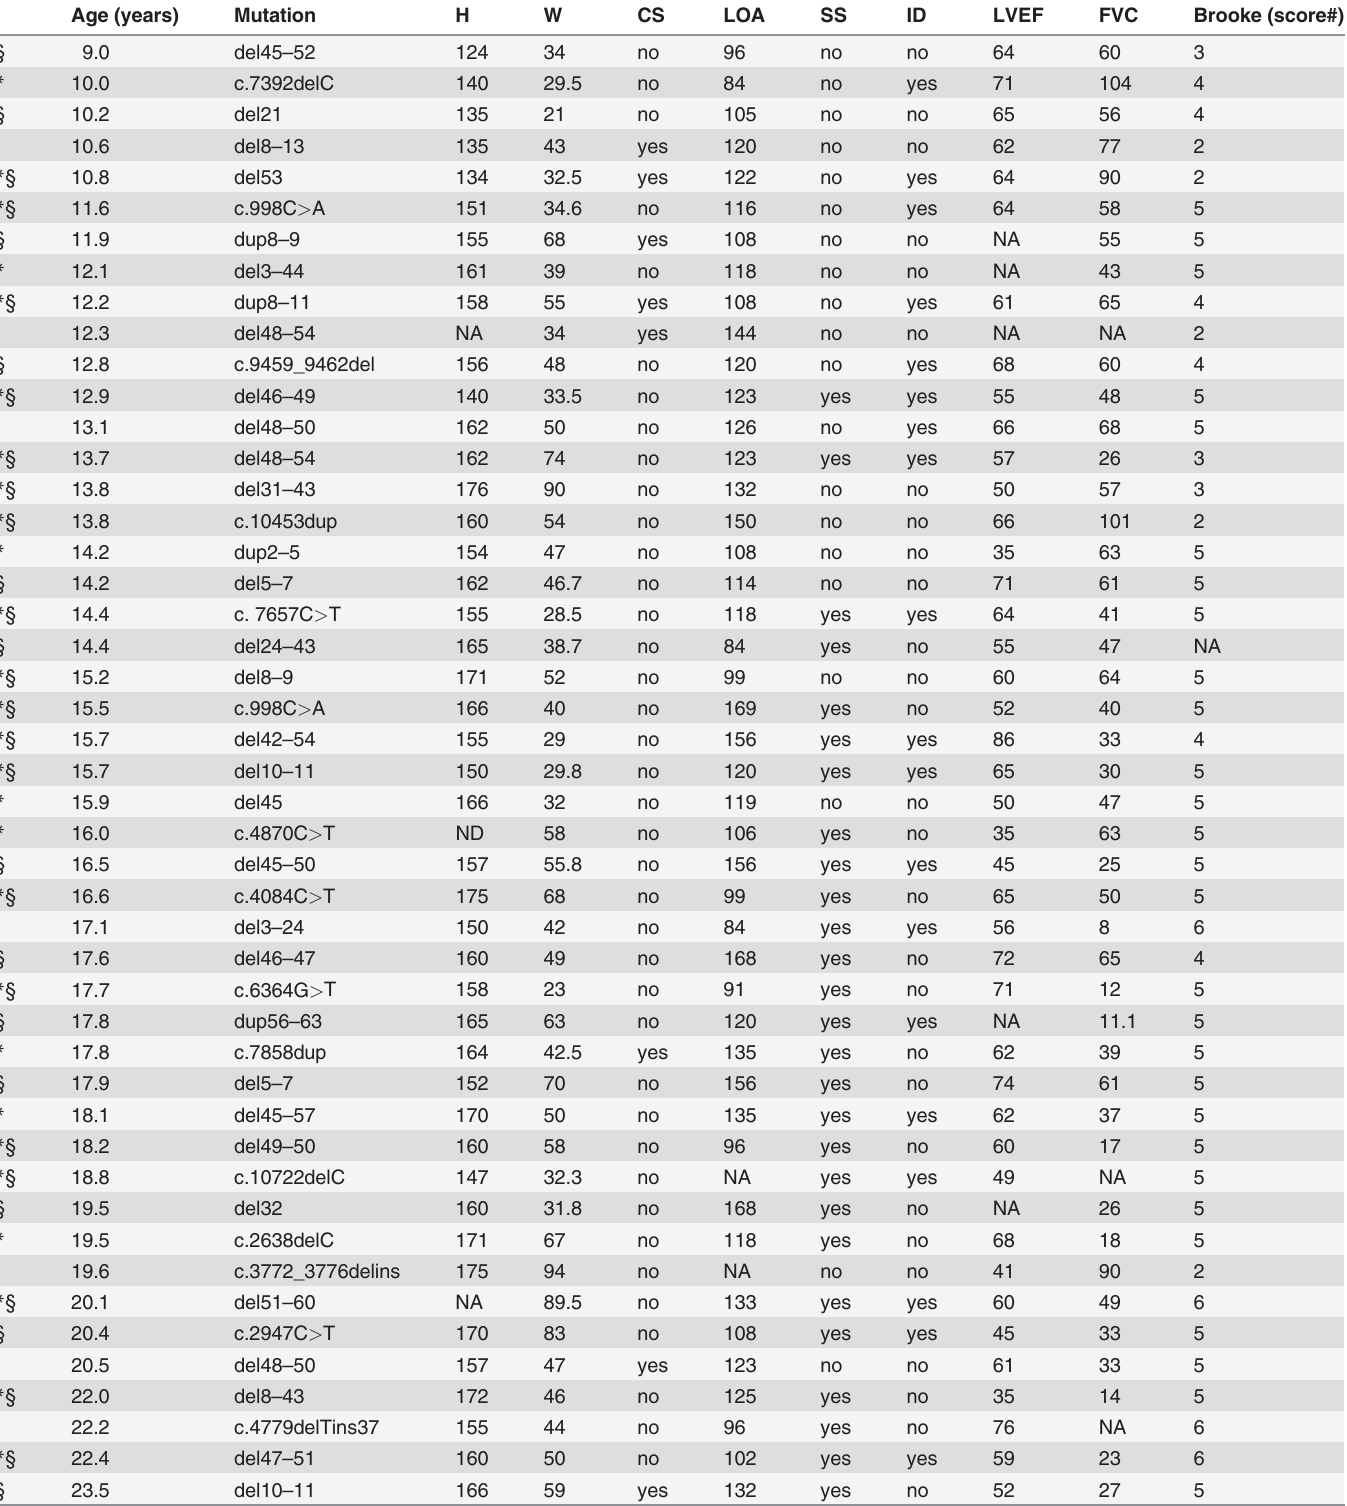
Table 1. Clinical data of all DMD patients sorted by